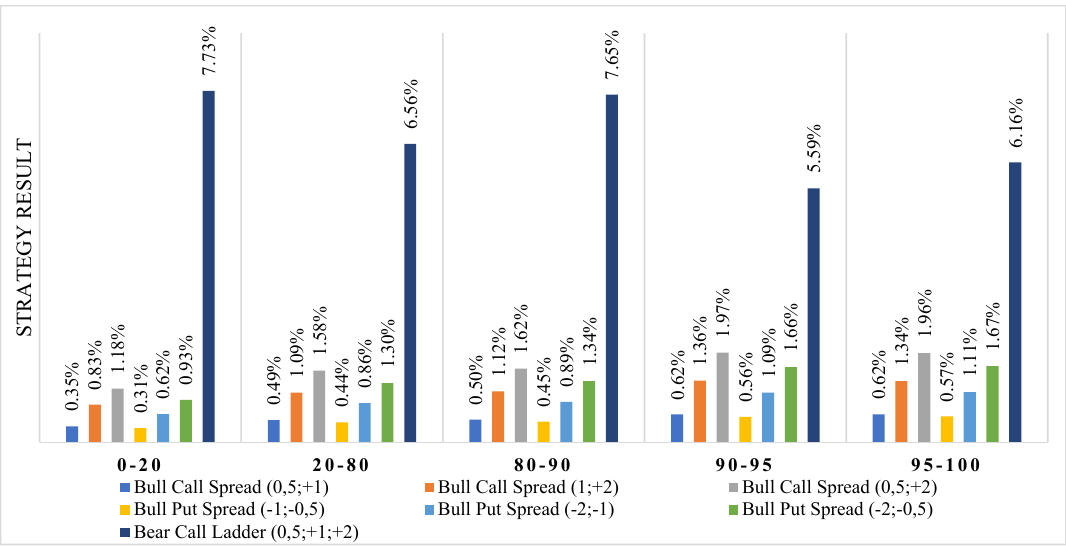
Figure 10. Bull Put Spread, Bull Call Spread and Bear Call Ladder results for increases of WTI Crude Oil prices exceeding 20%.